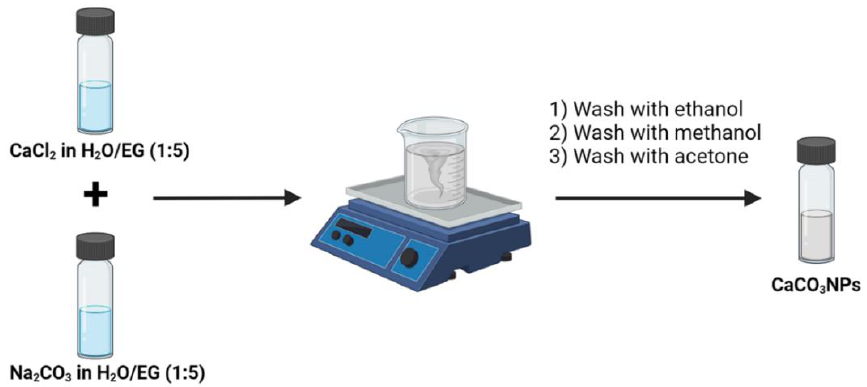
Figure 1. Schematic illustration of the procedure used for the fabrication of CaCO 3 NPs.